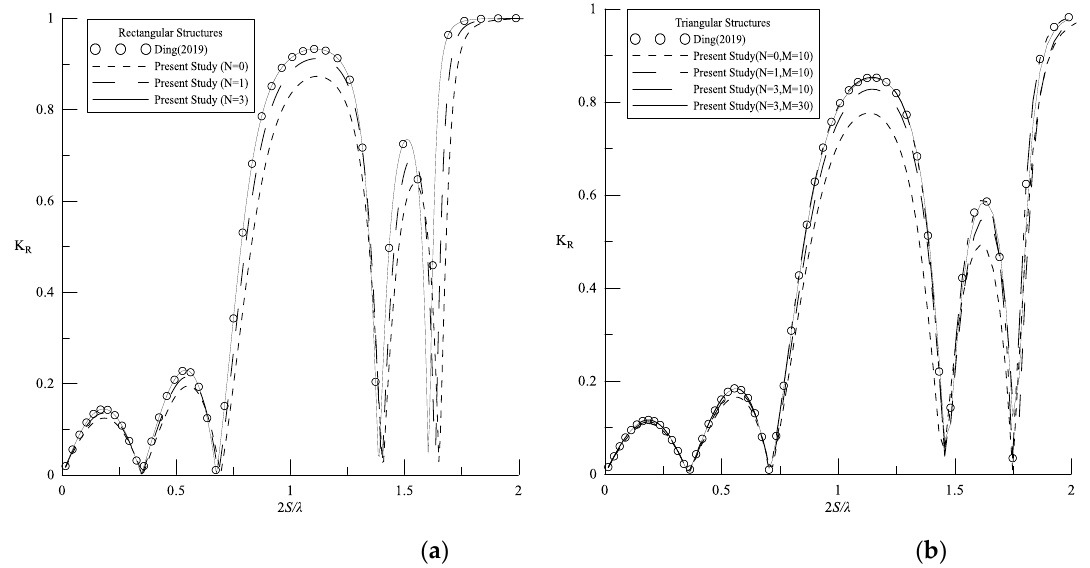
Figure 9. Comparison of the reflection coefficients from the present study with the results in the literature for Bragg reflections by periodic ( a ) rectangular and ( b ) triangular surface-piercing structures over flat bottom.